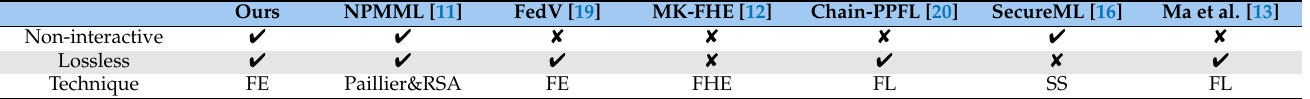
Table 2. Feature comparison of several superior